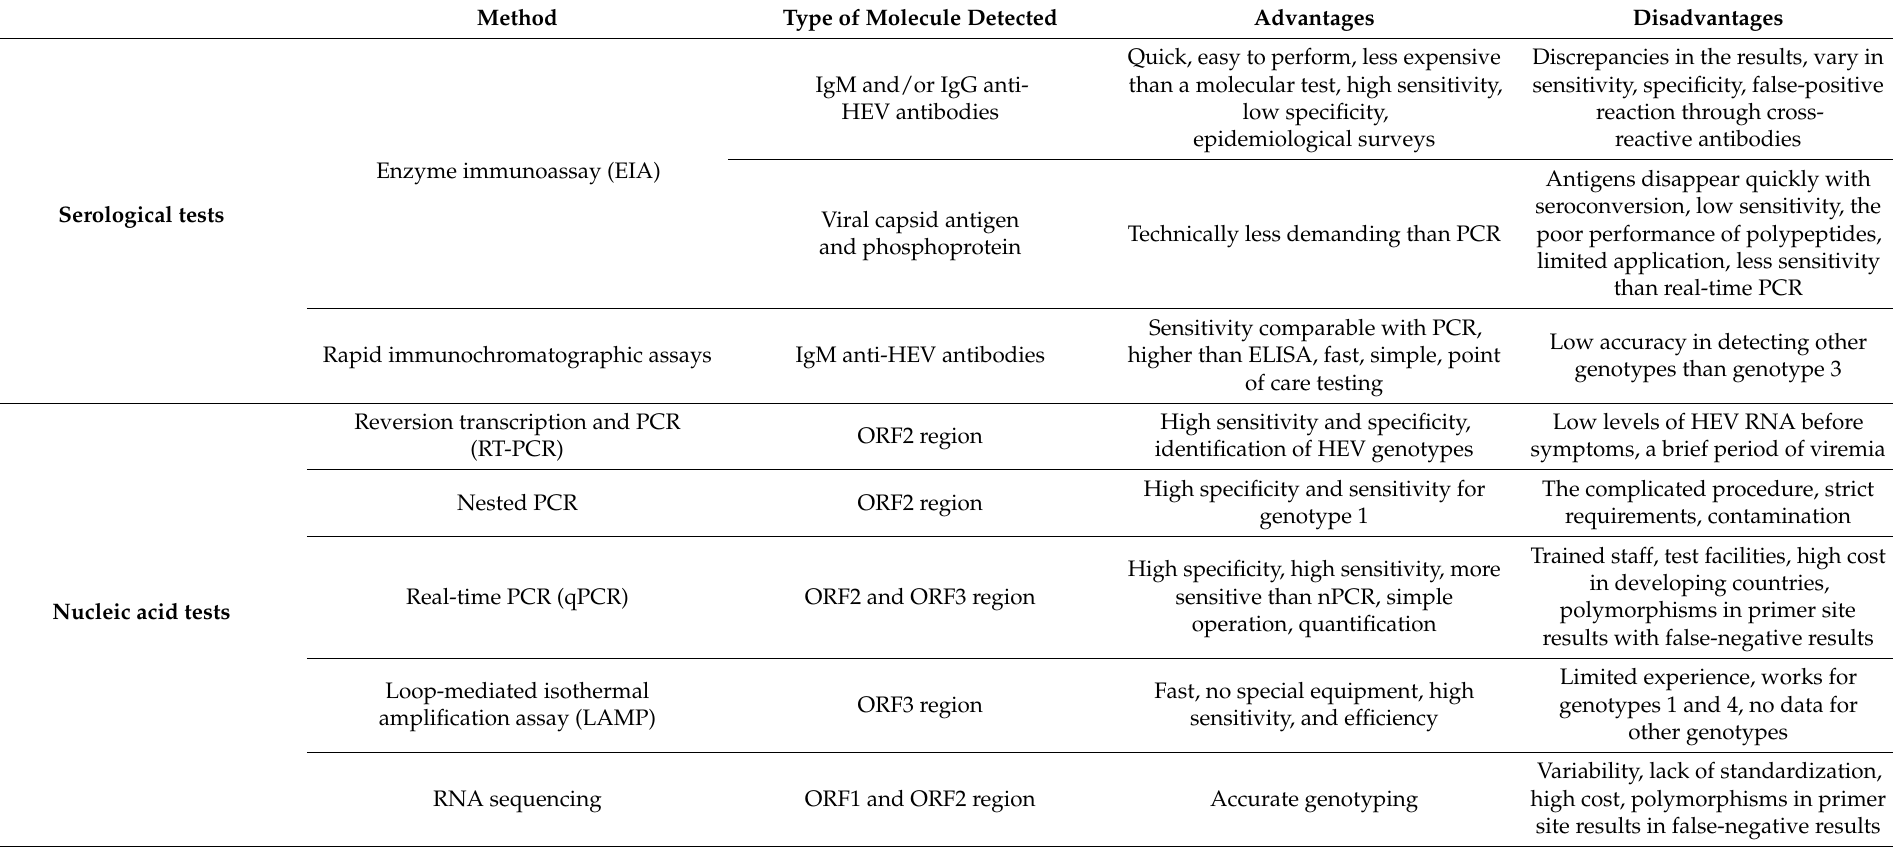
Table 3. The advantages and disadvantages of serological assays and the nucleic acid test for HEV diagnostic